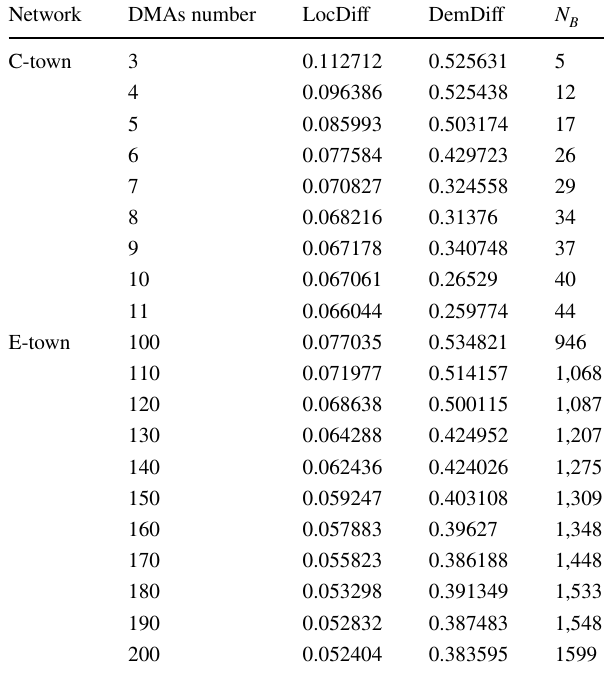
Table 3 Effect of number of DMAs on clustering results (aggregation range is set to 0)